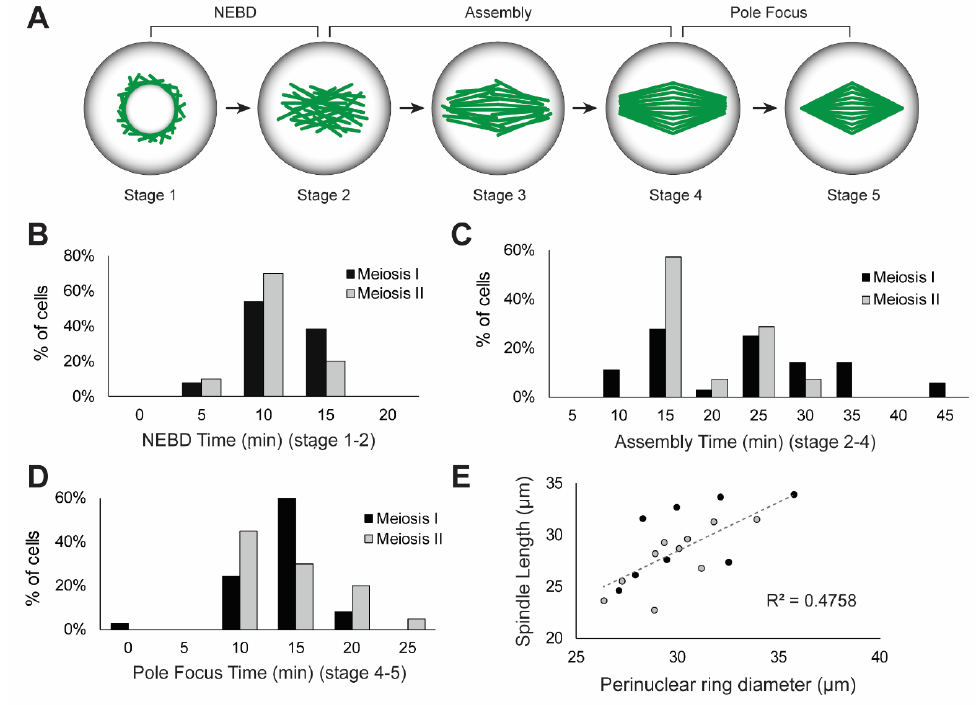
Figure 2. Dynamics of meiotic spindle assembly. ( A ) Meiotic spindle assembly is grouped into five stages; microtubules are shown in green and cell outline in black. Stage 1: nuclear envelope with surrounding microtubules. Nuclear envelope breakdown (NEBD) occurs in the transition from stage 1 to stage 2: collapse of microtubules into the nuclear space. Spindle assembly occurs from stage 2 through stage In stage 3, a spindle shape is emerging and by stage 4, a bipolar spindle with broad poles is visible. From stage 4 to the final stage 5 (fully formed bipolar spindle), the poles are focused to tight points. ( B ) Histogram of the NEBD time (stage 1–2) in meiosis I (black) and meiosis II (gray) cells. ( C ) Histogram of spindle assembly time (stage 2–4) in meiosis I and meiosis II cells. ( D ) Histogram of spindle pole focusing time (stage 4–5). ( E ) Linear correlation of spindle length with perinuclear ring diameter in meiosis I (black) and meiosis II (gray) cells ( n = 18). Spindles assemble in the nuclear space, initially creating a barrel shape with irregular microtubule structure (stage 3, Figure 1A T = 14, Figure 1B top cell T = 10–15min, bottom cell T = 5–10 min) that is organized into parallel microtubule bundles with a bipolar form (stage 4, Figure 1A T = 21, Figure 1B top cell T = 20 min, bottom cell T = 15 min). The time from collapsed microtubules (stage 2) to bipolar spindle (stage 4) was considered the spin- dle assembly time (Figure 2A). The average assembly time for meiosis I was 22.9 ± 9.6 min and 18.9 ± 5.5 min for meiosis II. While these averages are not statistically different, with a 95% confidence level cut-off ( p -value = 0.06, t -test), the variance in assembly time is sta- tistically different, with a greater variance in meiosis I assembly time ( p -value = 0.03, f- test). The variance can be seen in the histogram plot (Figure 2C), where meiosis I has a broader distribution of assembly times than meiosis II, which has a defined peak at 15 min. After creating a bipolar form, the spindle poles focus into tight points (stage 4–5). The focusing of the spindle poles is a uniquely meiotic feature, as mitotic plant spindles remain barrel shaped throughout chromosome segregation [28,30,32,45,49]. The average pole fo- cusing time was 13.2 ± 3.9 min for meiosis I and 13.7 ± 4.6 min for meiosis II (no statistical difference, p -value > 0.05, t -test), and they have a similar distribution of pole focusing time, with no difference in variation (Figure 2D).